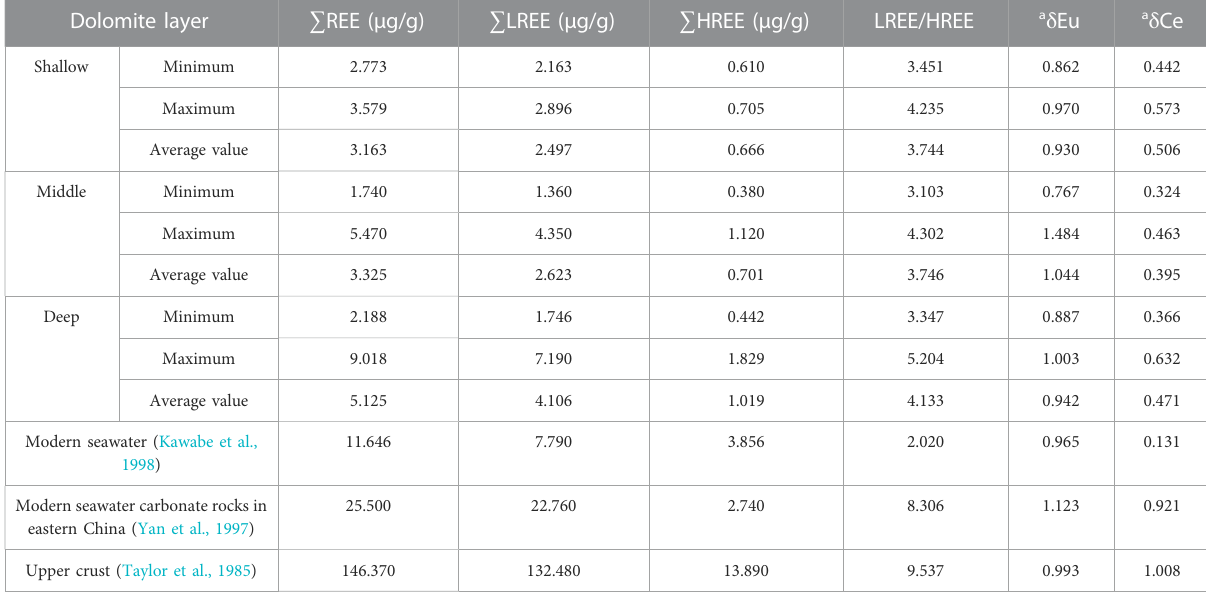
TABLE 7 Statistics of REE parameters of shallow, middle and deep dolomites. Dolomite